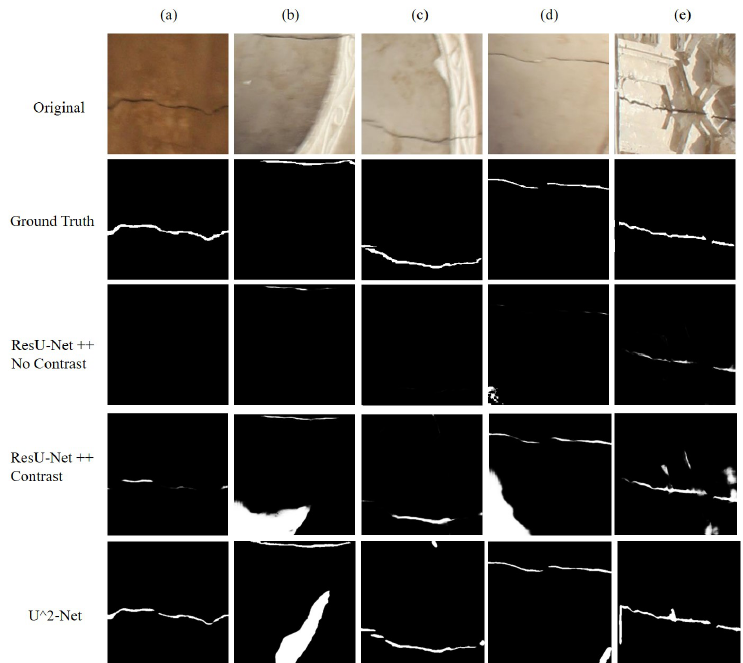
Figure 13. Results on several samples of the used crack detection dataset, with different patterns— group-2. In each column, we present the results based on: ( a ) Blurred image with a crack, ( b ) Wide crack with a marker, ( c ) Blurred image with a crack and texture, ( d ) Blurred image with a crack, ( e ) Image with a crack inside